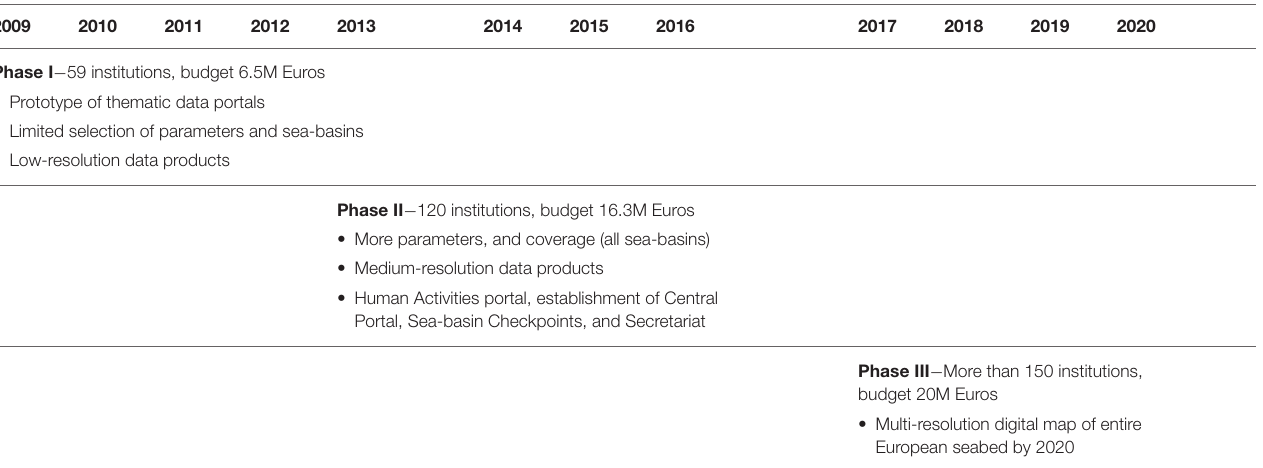
TABLE 1 | The three initial phases of EMODnet development up to